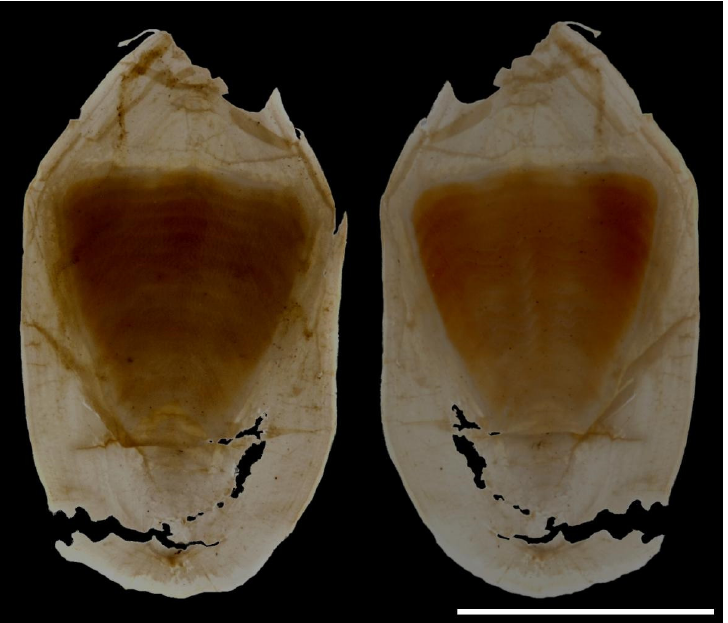
Figure A2. Dorsal ( left ) and ventral ( right ) aspects of the cuttlebone of the holotype of Sepia typica (Steenstrup, 1875) (NHMD-77360, female ML 26, 6gm, Zoological Museum, Copenhagen). Scale bar 10 mm.